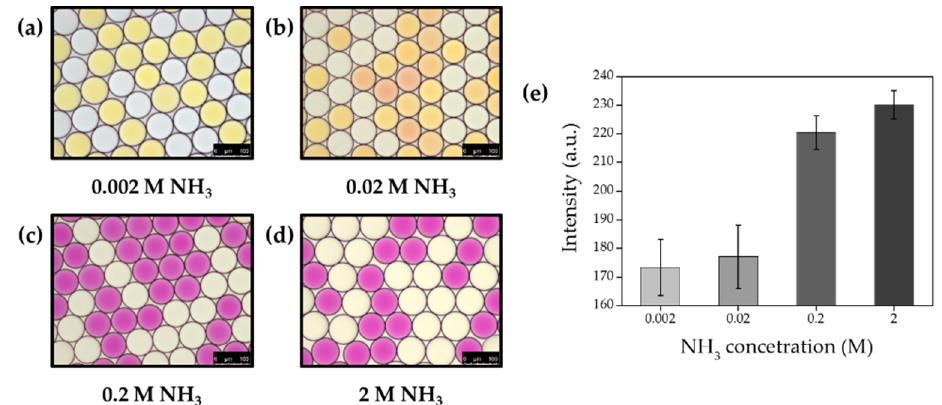
Figure 13. Permeability on ammonia gas concentration between droplets. Ammonia gas generating droplets were generated separately at ammonia gas concentration of 0.002 M ( a ), 0.02 M ( b ), 0.2 M ( c ) and 2 M ( d ) and mixed with indicator droplets, respectively. ( e ) Mean values of color exchange of indicator droplets for ammonia gas concentration (scale bar = 100 µ m).